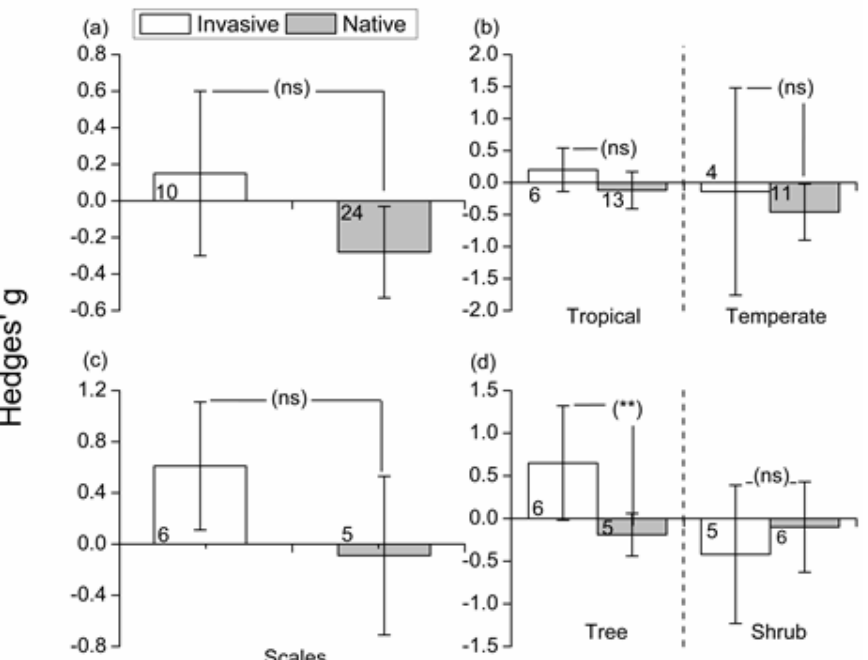
Figure 5. Mean effect size (Hedges’ g) and 95% confidence interval of the effect of exclusion of invasive or native ants on plant fitness ( a ) under different climate zone ( b ), Hemiptera type ( c ), and plant type ( d ). The sample size for each category is shown in parenthesis. ** p < 0.01, “ns” not sig- nificant.